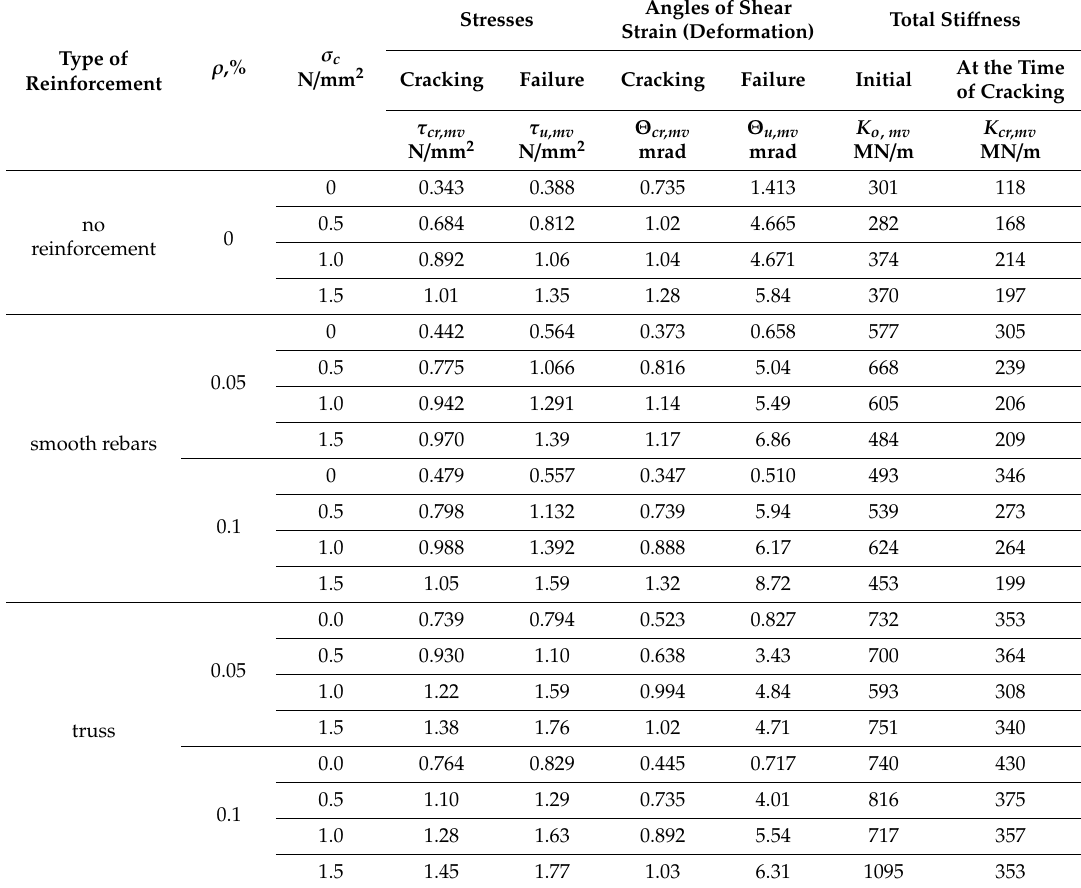
Table 4. Test results for solid brick